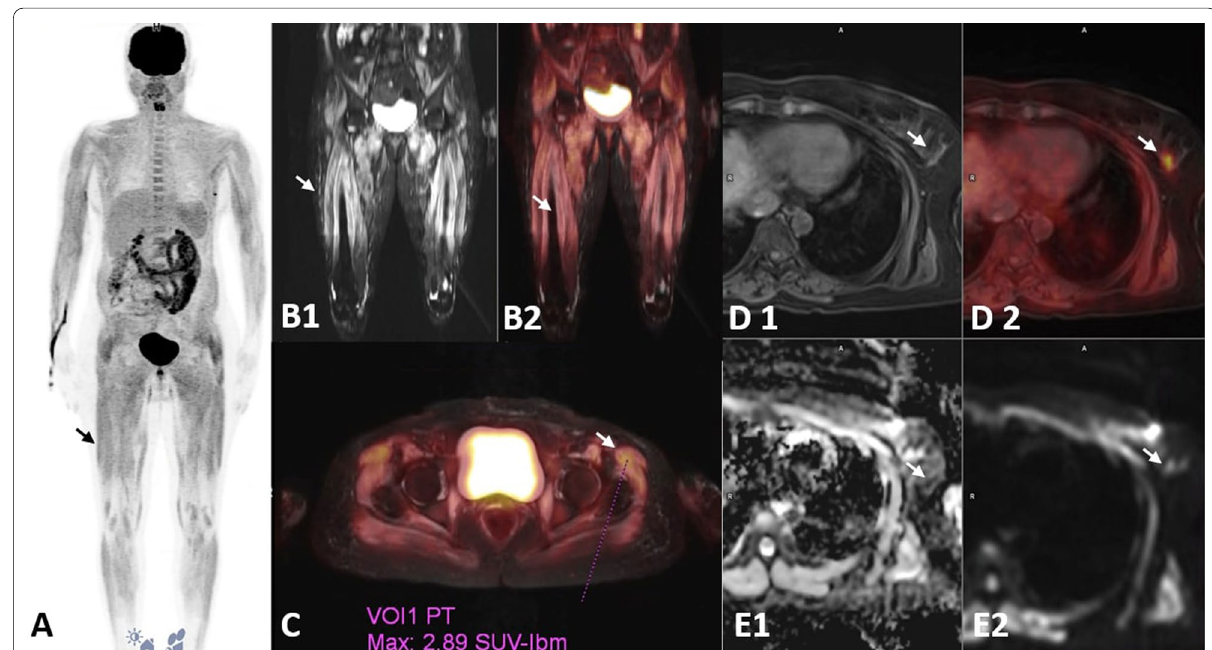
Fig. 1 PET‑MRI images of a 48‑year‑old lady with Dermatomyositis and Carcinoma Breast. A Whole body MIP image (black arrow). B1 Coronal T2 FS BLADE MR image showing hyperintensity changes in the proximal thigh muscles (white arrow). B2 Coronal fused PET/MRI image shows increased FDG uptake in all the proximal thigh muscles (white arrow). C Axial Fused T2FS BLADE MR/PET images showing increased FDG uptake in the hip girdle muscles with SUV max of 2.89 (white arrow). D1 and D2 . Axial Fused T1 VIBE DIXON (W) and fused PET/MR images showing focal lesion with increased FDG uptake in lower outer quadrant of the left breast (white arrow). E1 and E2 . Axial ADC and TRACE DWI MR images showing focal area of diffusion restriction corresponding to the focal lesion on PET (white